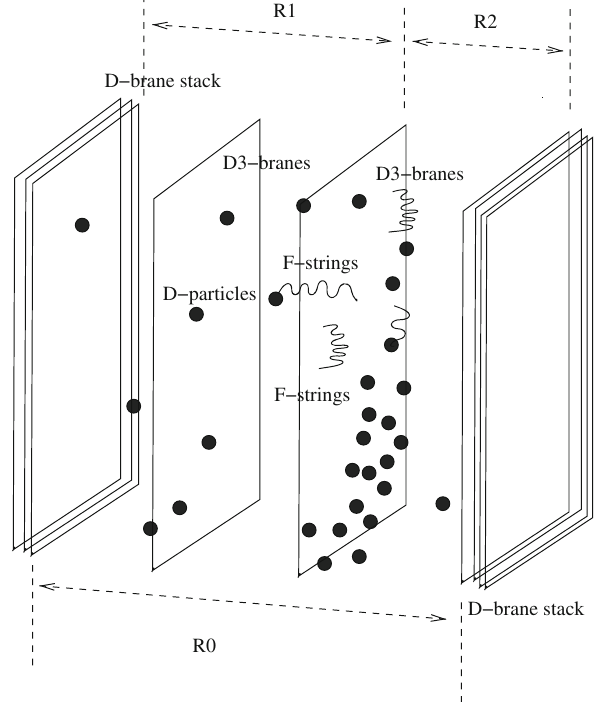
Fig. 1 Schematic representation of a prototype D-particle space–time foam model [16–18], consisting of two stacks of higher-dimensional D- branes, attached to orientifold planes, which, due to their special reflec- tive properties, provide a natural compactification of the bulk dimen- sion. The bulk is punctured by D0-branes (D-particles). Our “world” is one of the brane Universes, after appropriate compactification to three largespatialdimensions(D3branes).Openfundamental(F-)stringslive on the D3-brane world, representing matter excitations of the Standard Model. Matter can interact topologically with the D-particle defects in the foam, e.g. , through capture and splitting of the open string by the defect, re-emission of the open string, and recoil of the D-particle. In each such process there are distortions of the neighboring